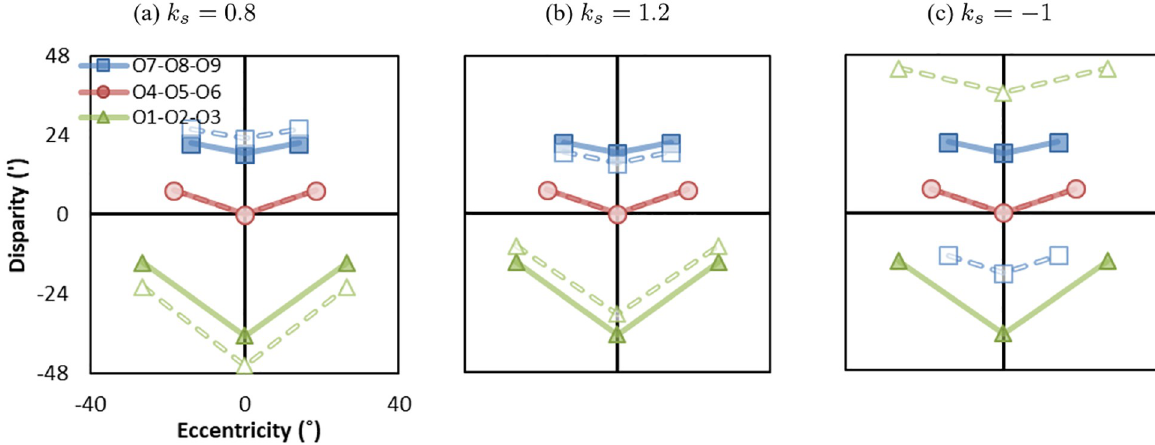
Fig 7. Effect of the separation mismatches. (a) Eye separation is smaller than camera separation ( k camera separation ( k eccentricity-disparity in the original world ( E